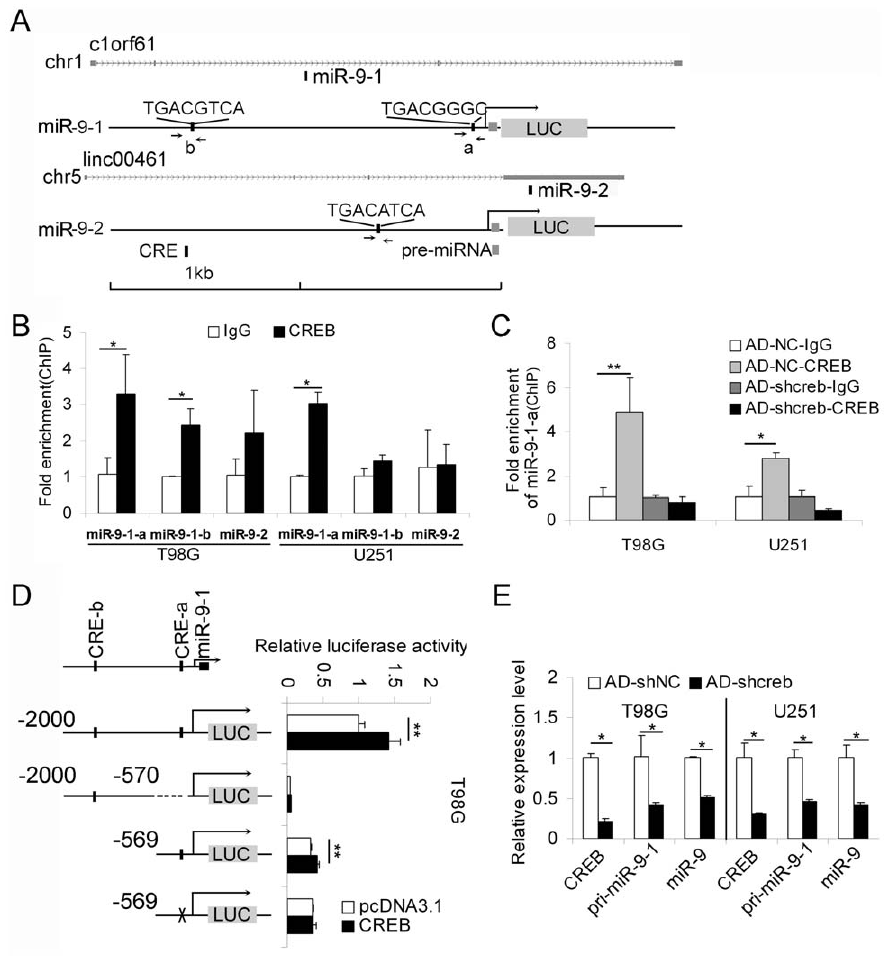
Figure 6. MiR-9-1 is under CREB’s control. (A) Location of putative CREs within the 5 9 flanking regions of miR-9-1 and miR-9-2. MiR-9-1 is located in an intron of the gene c1orf61 (chromosome 1), whereas miR-9-2 is located in an exon of linc00461 (chromosome 5). Three pairs of primers (miR-9- 1-a, miR-9-1-b and miR-9-2) were designed to detect the binding capacity of CREB to the predicted CREs of miR-9-1-a, miR-9-1-b and miR-9-2, respectively, by ChIP-qPCR assays. Both the 5 9 flanking sequences (2 kb) and the pre-miRNA bodies of miR-9-1 and miR-9-2 were inserted upstream of the luciferase reporter (gray box shown by LUC). The arrows denote the positions of primers used for ChIP-qPCR. (B) ChIP-qPCR assays were performed in T98G and U251 cells to detect the binding capacity of CREB to the putative CREs of miR-9-1 and miR-9-2 (mean 6 SD, n=3). (C) In AD- shNC/AD-shcreb-infected T98G and U251 cells, ChIP-qPCR was performed to detect the binding capacity of CREB on CRE-miR-9-1-a (mean 6 SD, n=3). (D) CREB enhances the transcription of miR-9-1. The 5 9 flanking sequences ( 2 2 kb + miR-9-1; 2 2 kb, 2 570 bp; 2 560 bp + miR-9-1) without mutations or with a mutation of CRE-a ( 2 569 + miR-9-1, from TGACGGGC to TGGAGGGC) in miR-9-1 were inserted upstream of the luciferase cassette. The luciferase reporter constructs were co-transfected with CREB expression plasmids or control vectors and the normalized luciferase activity was determined (mean 6 SD, n=4). (E) The mRNA expression levels of CREB, pri-miR-9-1 and mature miR-9 were detected in T98G and U251 cells infected with AD-shcreb or AD-shNC by quantitative RT-PCR (mean 6 SD, n=3). *, P , 0.05, **, P , 0.01, two-tailed unpaired Student’s t